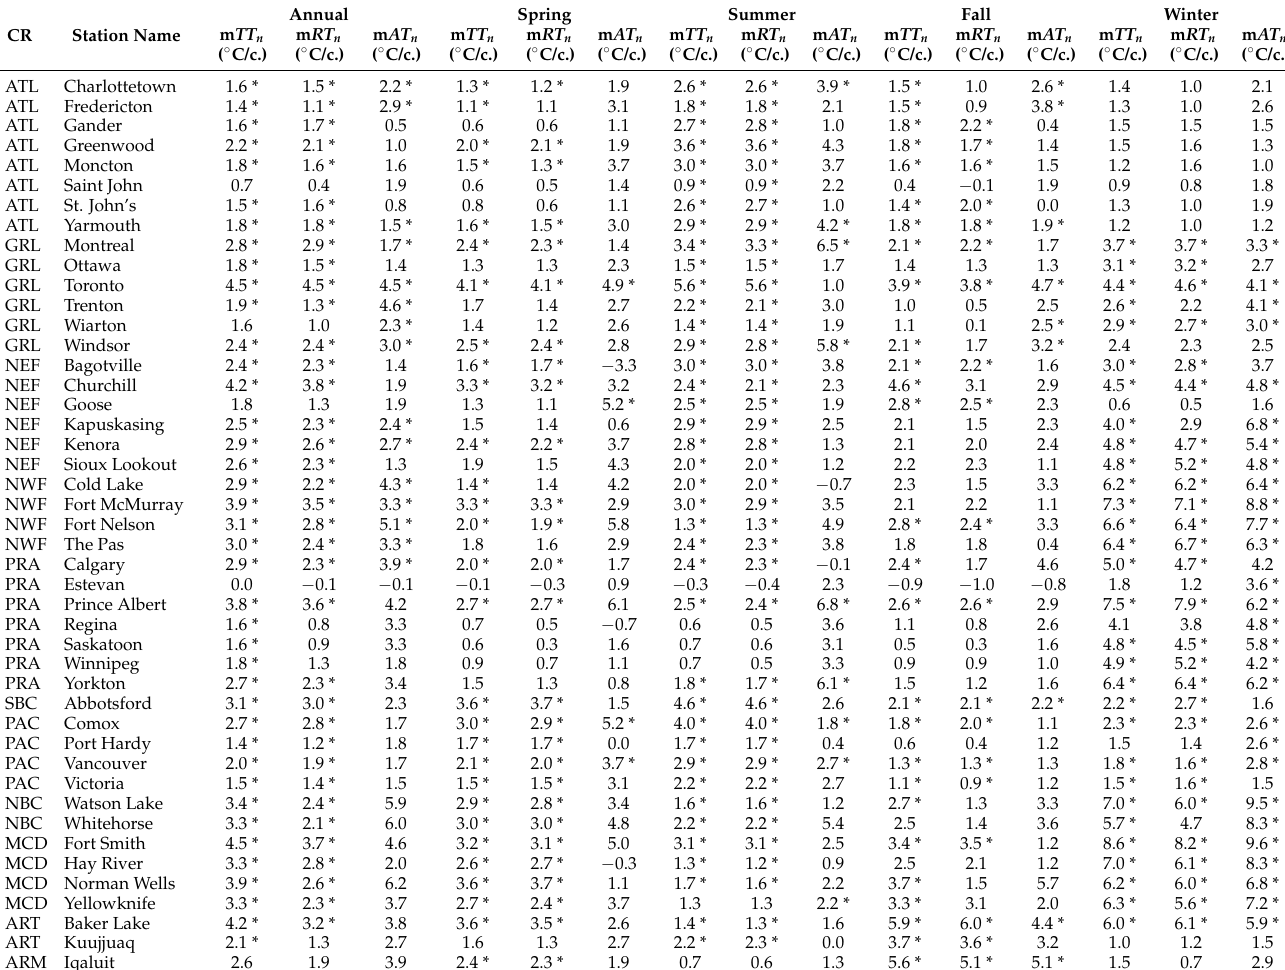
Table 4. Temperature Minima Slopes reported in degrees Celsius per century ( ◦ C/c.) “m” represents